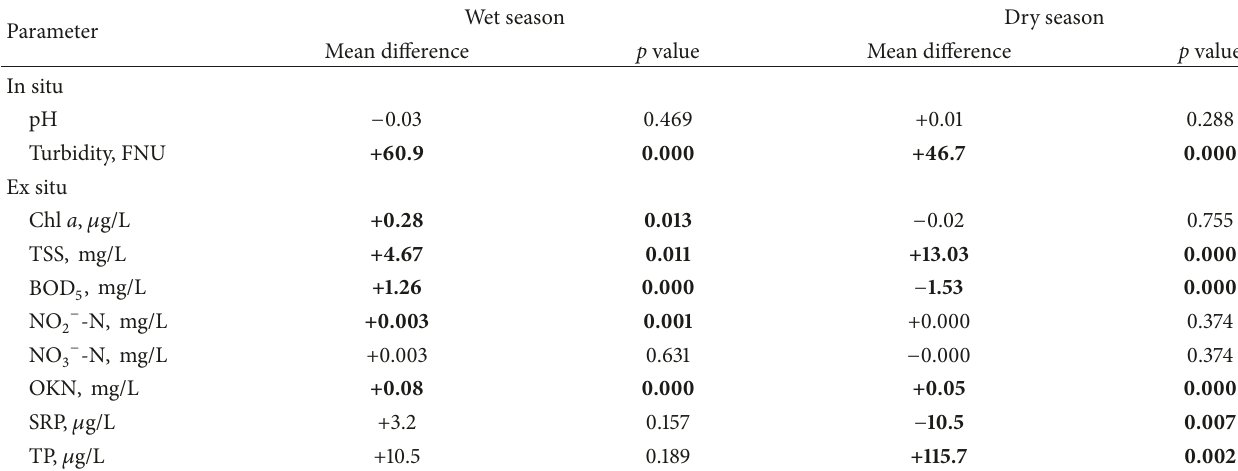
Table 6: Mean difference of in situ and ex situ water quality parameters between the intake point of the dam at 10 m (Station 5) and its downstream river (Station 6) during wet and dry seasons ( 𝑁 = 3